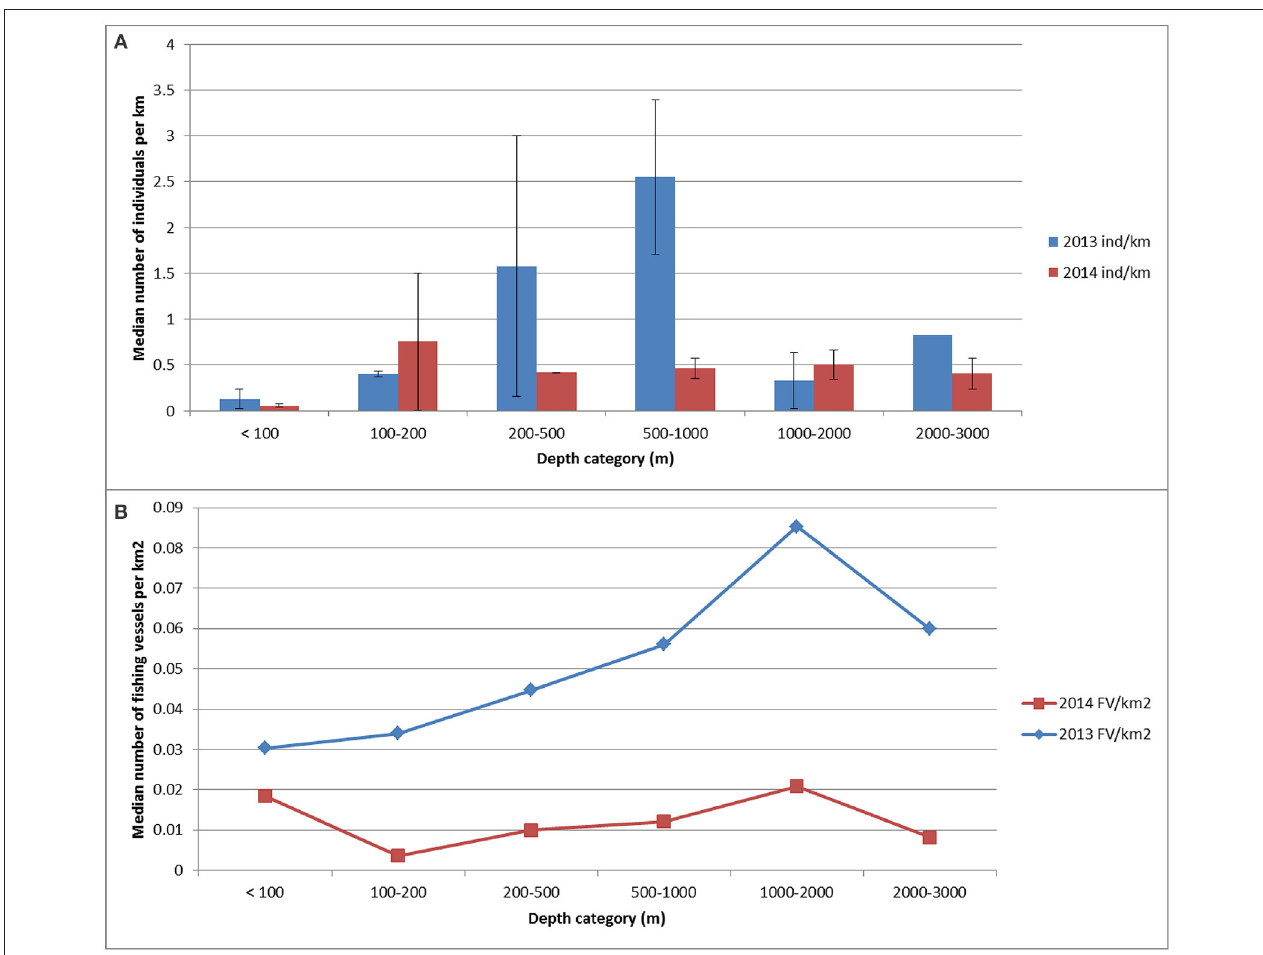
FIGURE 2 | The (median) indices of abundance for cetaceans (number of animals km − 1 of search effort) computed for the following water depth categories: < 100m; 100–200m; 200–500m; 1000–2000m and 2000–3000m water depth for each survey year (A). The density for fishing vessels (number of fishing vessels km − 2 ) for each depth category is also shown (number of vessels km − 2 ) for each survey year (B)